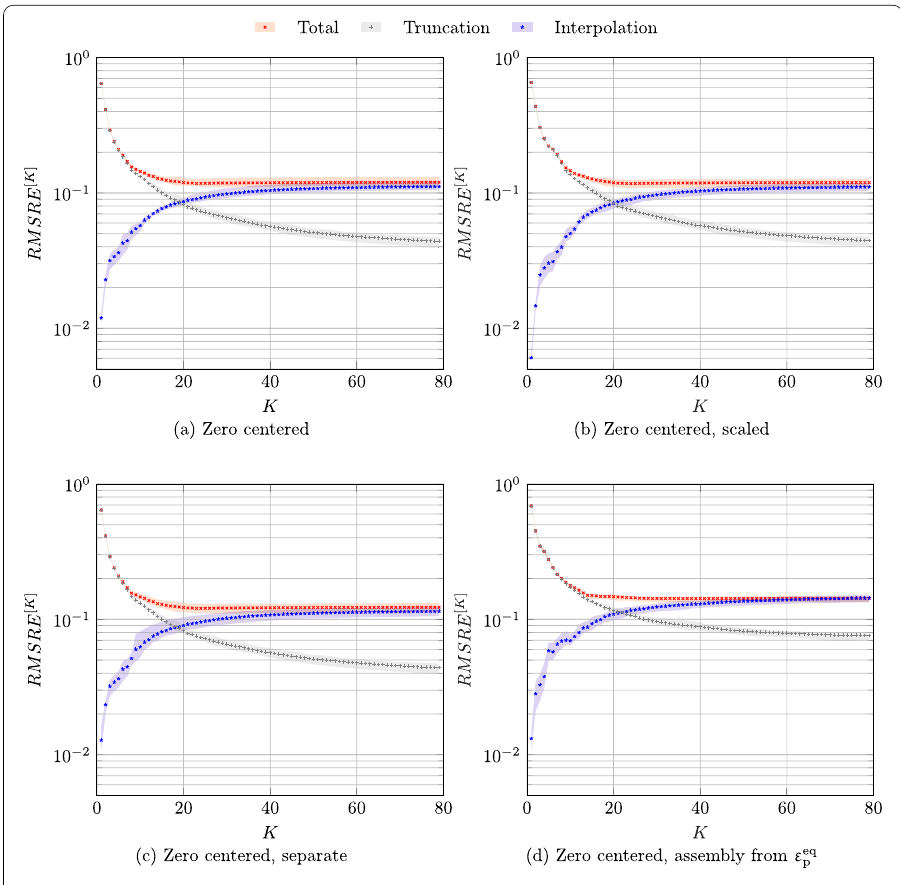
Fig. 12 RMSRE of the stress field of the industrial bending problem using 4 different methods for surrogate model construction. The markers represents the mean over the 5 training sets. The shaded area represents the range over all training sets